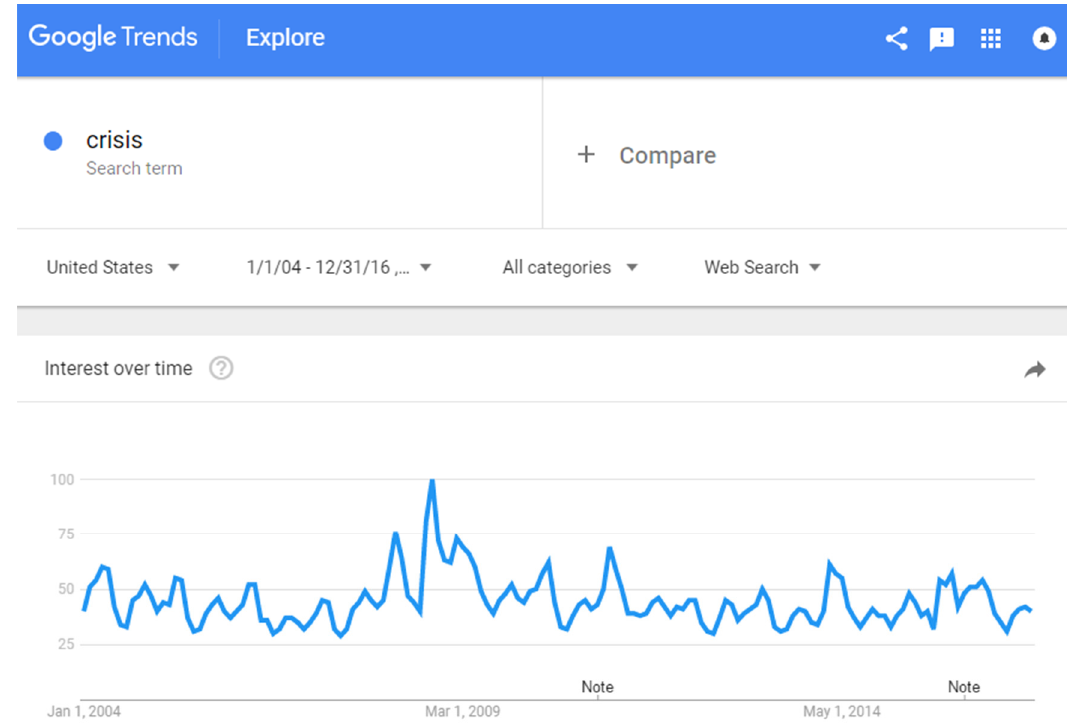
Figure 1. Sample of Search Volume Index (SVI) on Google for the word “crisis”. Note: This figure presents the search volume index (SVI) for the search term “Crisis” from January 2004 to December 2016. Increases in SVI imply an increase in the search term “Crisis” in the United States according to Google Trends. Source: Google Trends (www.google.com/trends, accessed on 16 March 2018).